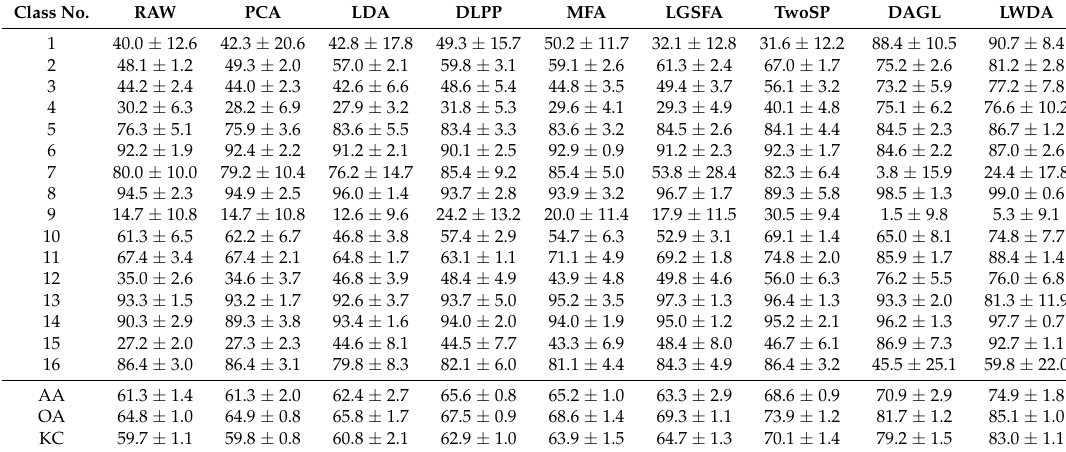
Table 2. Classification results (%) of each class ( τ = 0.05) with nearest-neighbor (NN) classifier on the Indian Pines dataset.